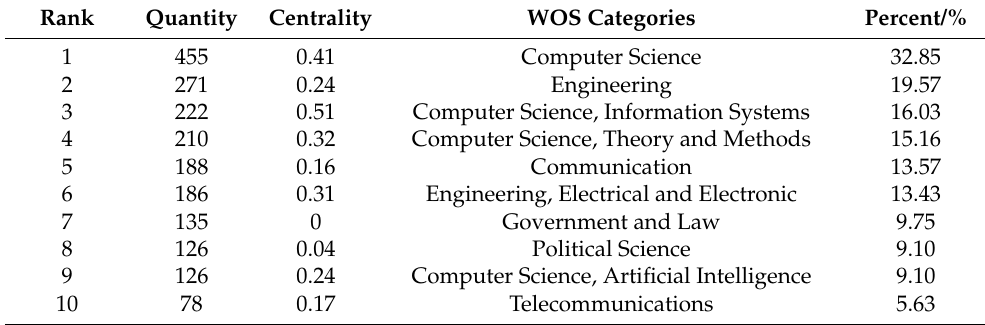
Table 3. The top 10 subject categories in NPO studies, 1990–2020.